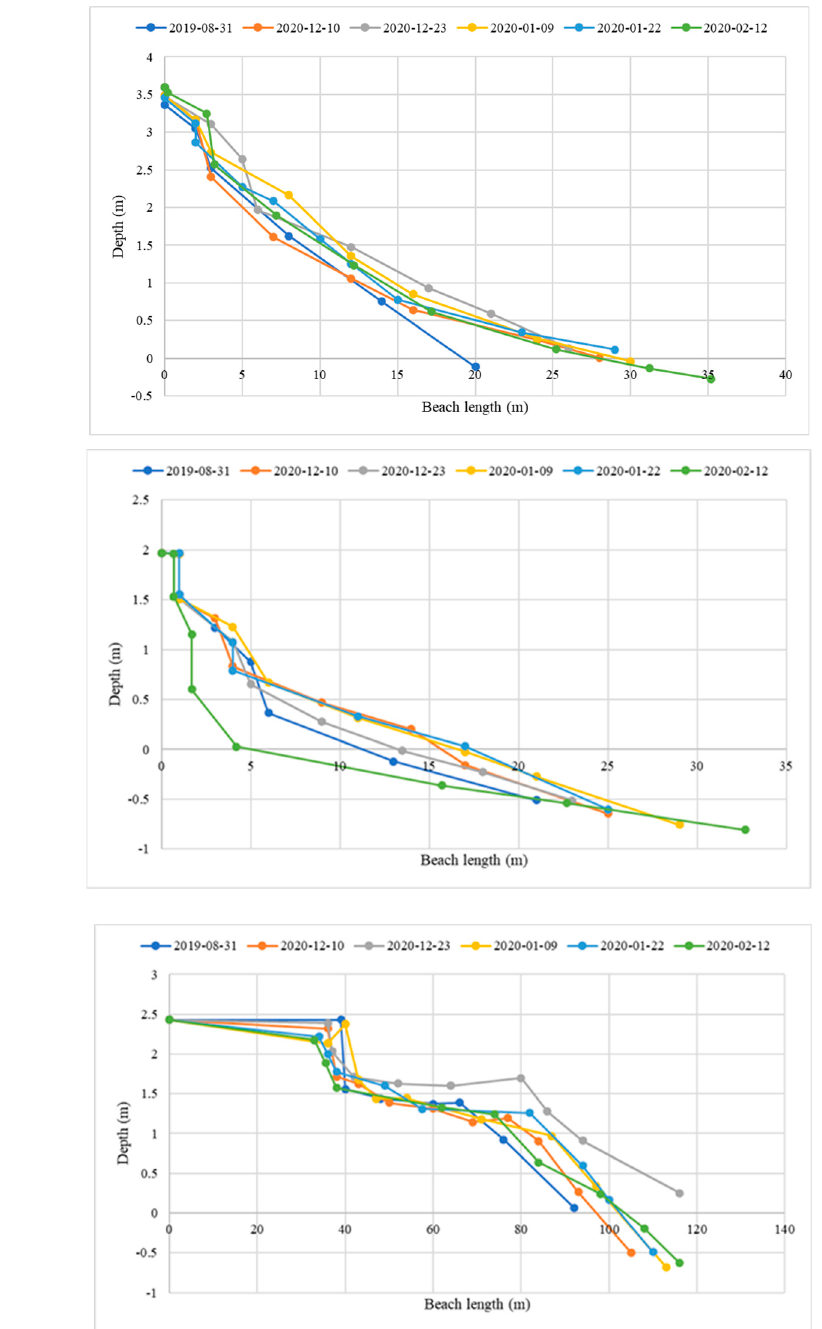
Figure 4. ( a ) Maloney’s Beach profiles from 2019-08-31 to 2020-02-12; ( b ) Cullendulla Beach profiles from 2019-08-31 to 2020-02-12; and ( c ) Corrigans Beach profiles from 2019-08-31 to 2020-02-12.